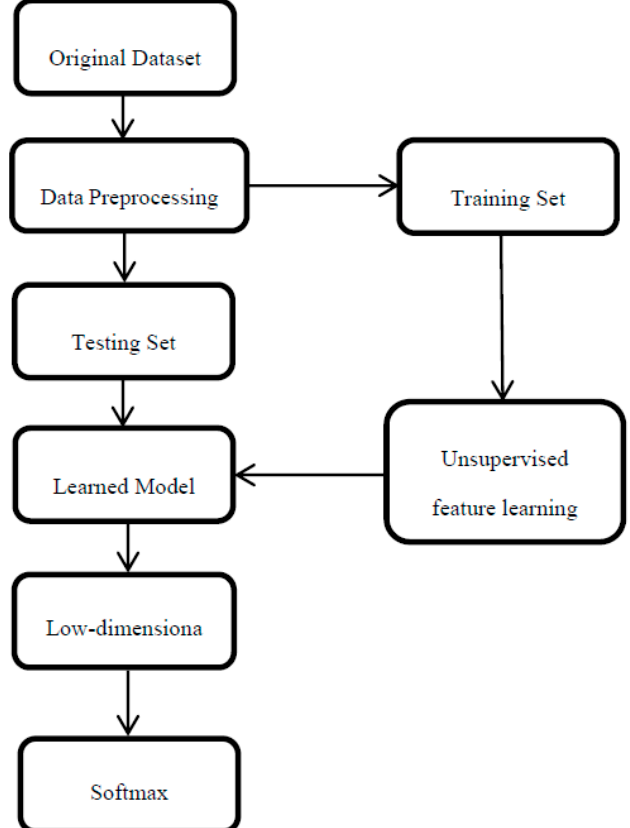
Figure 2. Flowchart of the methodology.